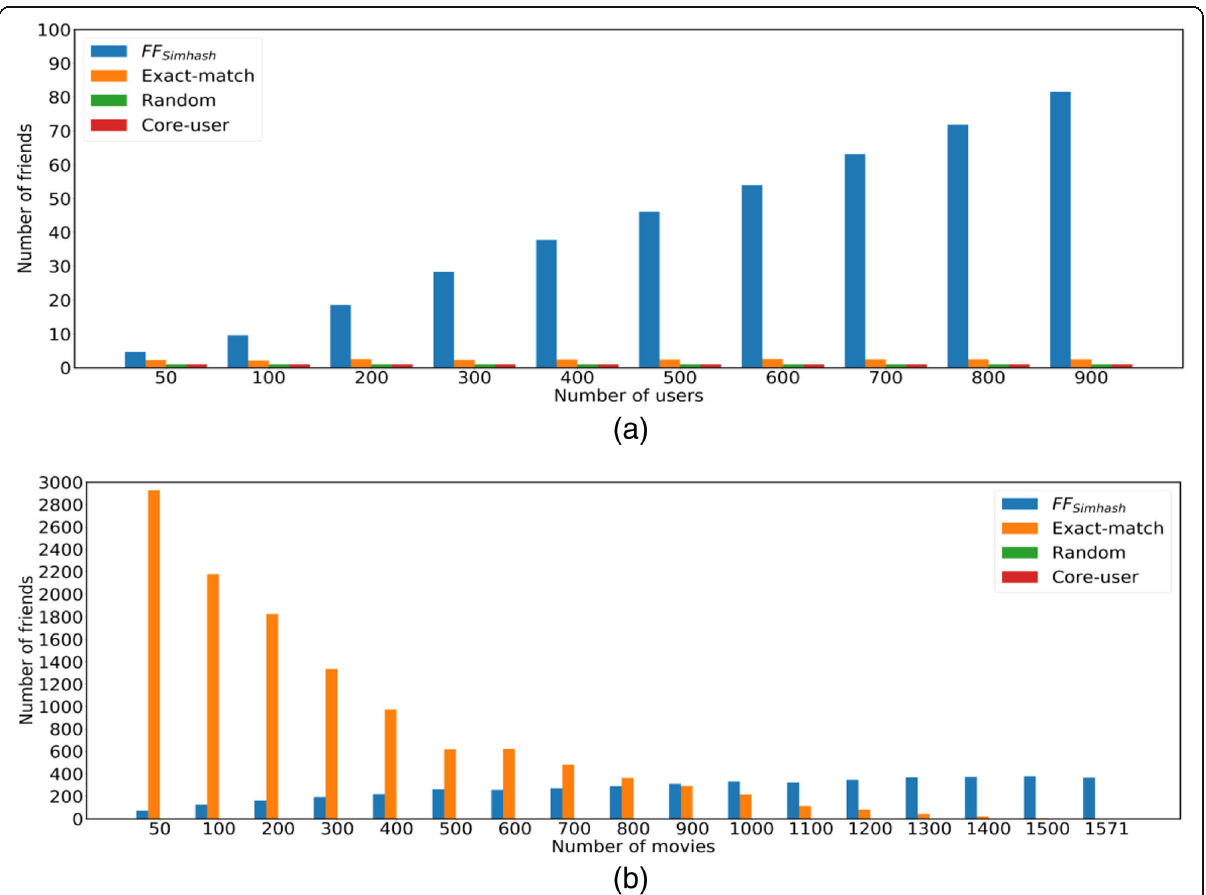
Fig. 3 a , b Number of returned friends of u